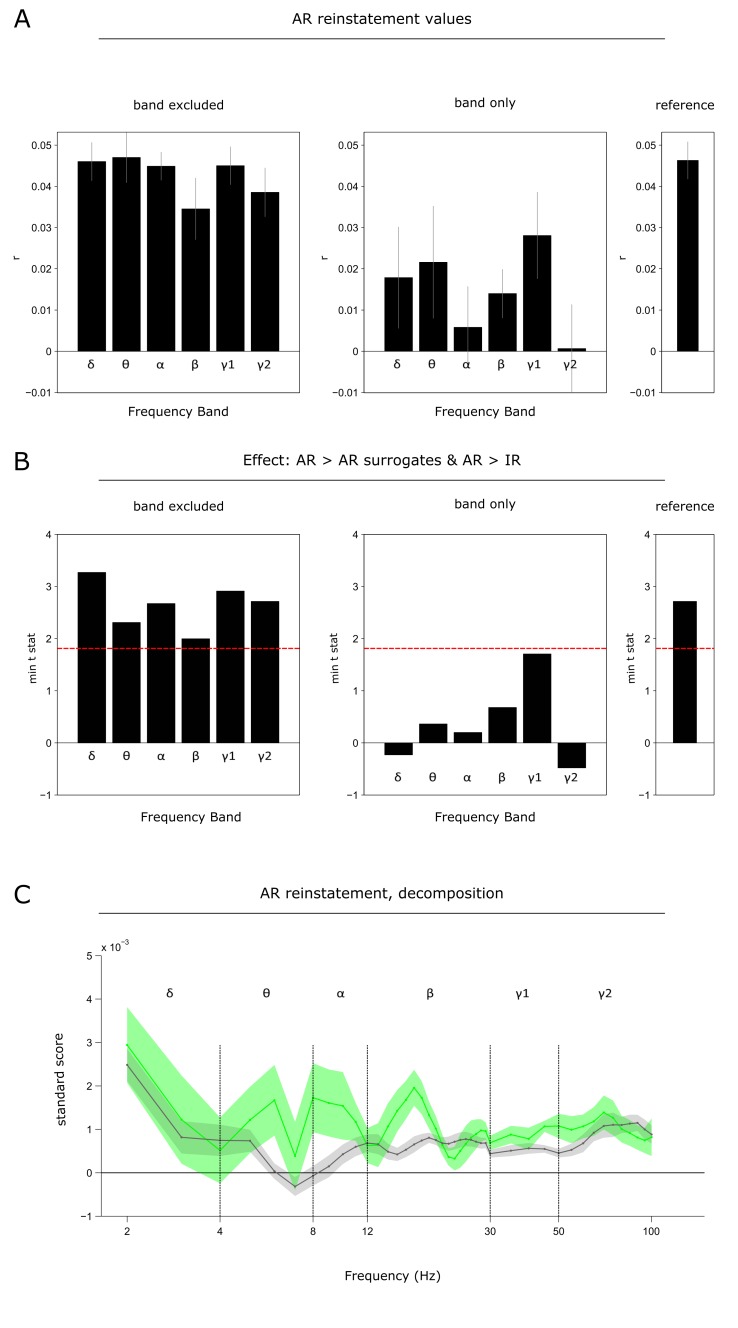
Contributions of different frequency bands to reinstatement.Analyses were conducted using a 400 ms time-frequency window centred on 0.75 s at encoding and 1.25 s at retrieval (where the maximum effect was observed in the main analysis, Figure 2C). (A) Reinstatement values for AR after selectively excluding (left) or only including (right) a particular frequency band. ‘Reference’ denotes the reinstatement value when including all frequency bands (c.f., Figure 2A). Bars show mean ± s.e.m. across participants (n=11). In a repeated measures ANOVA on reinstatement values including the factors Set (excluded, only) and Frequency Band (δ, θ, α, β, γ1, γ2), there was a significant main effect of Set (F(1, 10) = 83.43, P<0.001), but no main effect of Frequency Band (F(2.63, 26.28) = 1.95,P = 0.153) nor a Set x Frequency Band interaction (F(2.61, 26.06) = 0.58, P = 0.608). Note also that there was no effect of Frequency Band when analysing each set separately [band excluded: F(1.96, 19.59) = 2.44, P = 0.114; band only: F(2.57, 25.66) = 0.99, P = 0.403]. (B) Effect sizes (minimum t of the conjunction AR > AR surrogates & AR > IR) after selectively excluding (left) or only including (right) a particular frequency band. ‘Reference’ denotes the effect when including all frequency bands (c.f., Figure 2C). Dashed horizontal red line denotes the critical t value for P<0.05 (df = 10), uncorrected. (C) Decomposition of the ‘reference’ reinstatement into contributions of each frequency (‘correlation weights’): the product of normalized ‘standard scores’ was calculated for each time-frequency bin in the 400 ms window centred at 0.75 s encoding/1.25 s retrieval. To yield the relative contribution of each frequency to the observed correlation, these scores were summed across the 41 time bins. Note that the sum of these correlation weights along the frequency axis would again be the correlation coefficient between the encoding and retrieval time-frequency window (‘reference’). Correlation weights are separately shown for AR (green) and AR surrogates (grey). Frequencies are plotted on a log scale. Vertical lines show transitions between δ, θ, α, β, γ1 and γ2 bands. A repeated measures ANOVA including the factors Condition (AR, AR surrogates) and Frequency (2:1:29 30:5:100) on these correlation weights revealed only a main effect of Condition (F(1, 10) = 10.09, P = 0.010; reflecting the greater reinstatement for AR than for AR surrogates), and no main effect of Frequency F(5.98, 59.83) = 1.74, P = 0.128) nor a Condition x Frequency interaction (F(5.65, 56.49) = 1.32, P = 0.267).